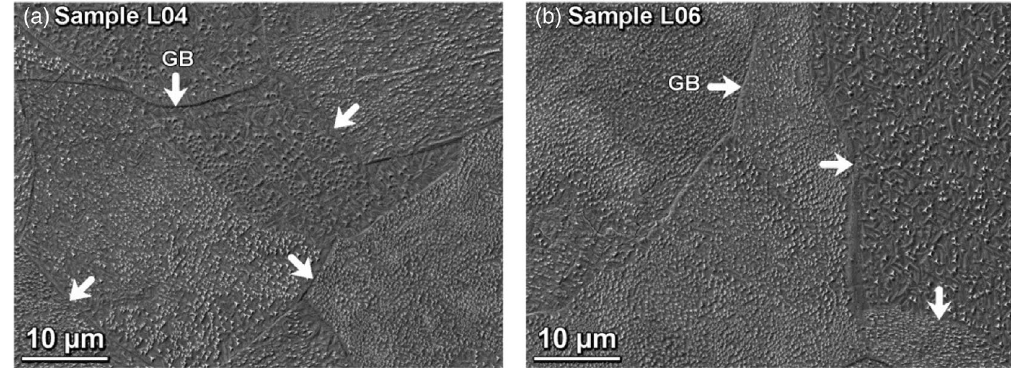
FIG. 1. FESEM SE images, showing the surface of two Nb coupons (a) L04 and (b) L06 both treated with high temperature nitrogen doping steps ( 800 °C for 3 hours followed by nitrogen exposure at 800 °C for 2 minutes and anneal for 6 minutes without nitrogen). The surface shows the formation of nonsuperconducting niobium nitride phase.